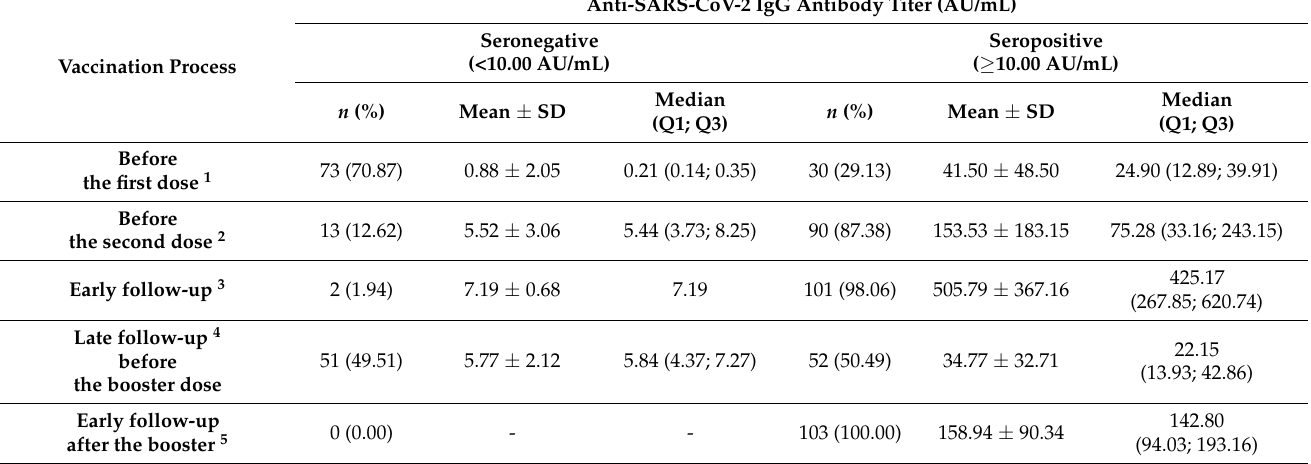
Table 2. Anti-SARS-CoV-2 IgG titer concentration in seronegative and seropositive participants at selected points of the time during the vaccination process with the BNT162b2